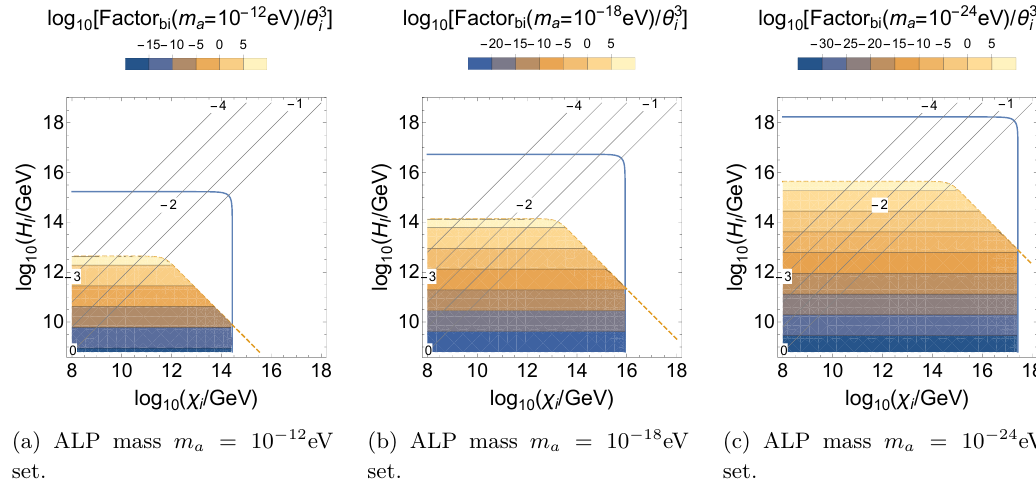
log 10 [ Factor bi ( m a = 10 - 12 eV )/ θ i 3 ]